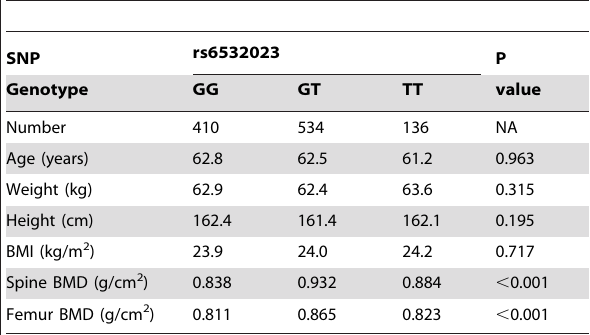
Table 3. Characteristics of the associated SNP rs6532023 in the total group of subjects.